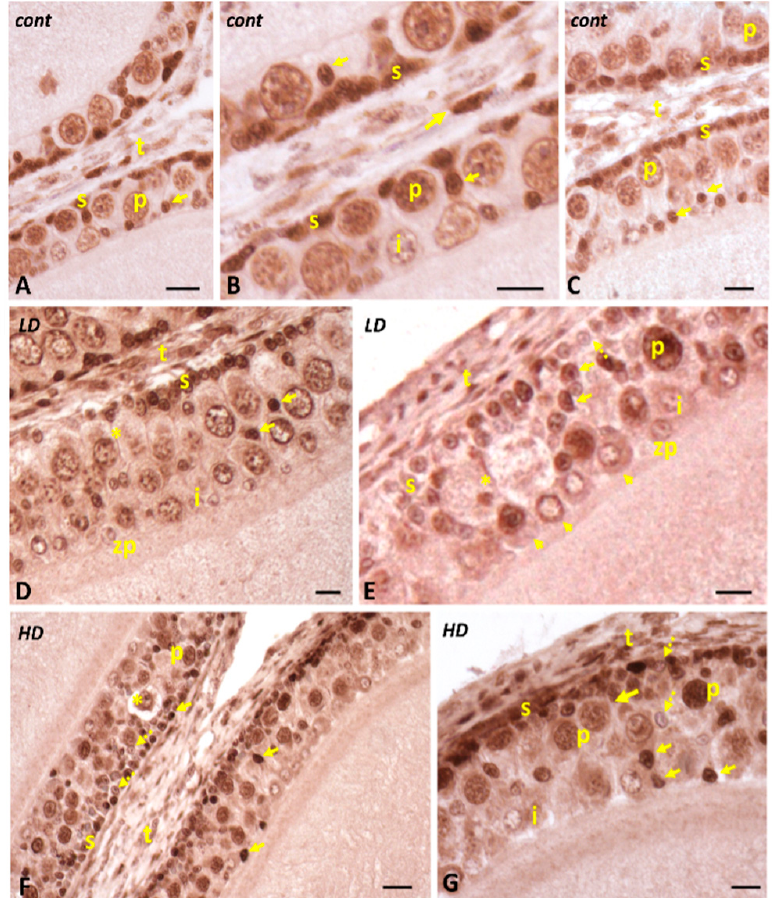
Figure 7. Immunohistochemical localization (brown areas) of PCNA in follicles of P. siculus treated with low (LD) or high (HD) doses of glyphosate. ( A – C ) Signal is evident on small (s) and theca cells’ (t) nuclei and on the nuclei of S cells migrating toward the zona pellucida (arrows). Intermediate (i) and pyriform (p) cell nuclei are moderately stained. ( D ) Intensely stained small (s) and theca (t) cell nuclei. Notice the stain on migrating S cells (arrows) and the presence of early apoptotic pyriform cells (*). ( E ) Stained small (s), pyriform (p), and theca (t) cell nuclei. Notice the stain on migrating S cells (arrows) and nuclei and/or cytoplasm of intermediate cells (i) (arrowheads). Occasional unstained S cells (dotted arrow) and apoptotic pyriforms (*). ( F , G ) Stained (arrows and unstained (dotted arrows) small cell nuclei. Notice the stain on migrating S cells (arrows), the occasionally unstained S cells (dotted arrows), and the presence of apoptotic pyriforms (*). Scale bars: 20 µ m. 2.5. Effects of Glyphosate on the Presence and Localization of Alpha and Beta Estrogen Receptors Glyphosate exposure causes a significant variation in both ER- α (Figure 8 left panels) and ER- β (Figure 8 right panels). In controls (Figure 8A,B), the signal is low and homoge- neously distributed on the epithelium and the theca. The zona pellucida and the oocyte are completely unstained. The signal increases dose-dependently in animals treated with glyphosate. At a low dose (Figure 8C,D), a stain appears on the cytoplasm of occasional intermediate and pyriform cells; at a higher dose, the number of stained cells significantly increases and, occasionally, small and theca cells also become stained (Figure